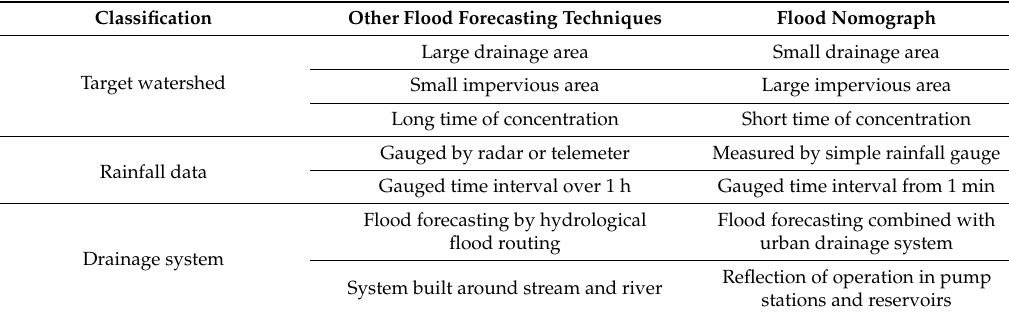
Table 2. Requirements of the flood nomograph and other flood forecasting techniques.